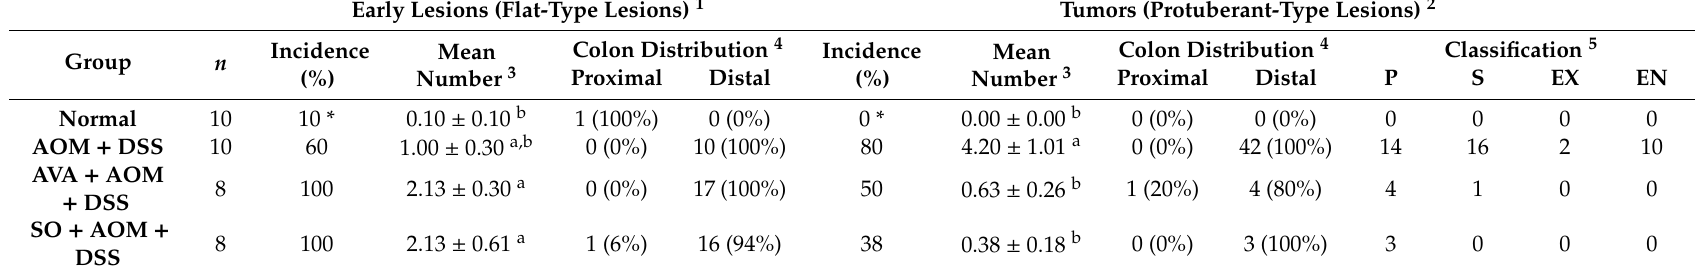
Table 3. Anticarcinogenic e ff ect of sprouted oat (SO) and its phenolic AVA extract (AVA) on the macroscopic quantitative classification of colonic lesions induced with AOM + DSS in CD-1